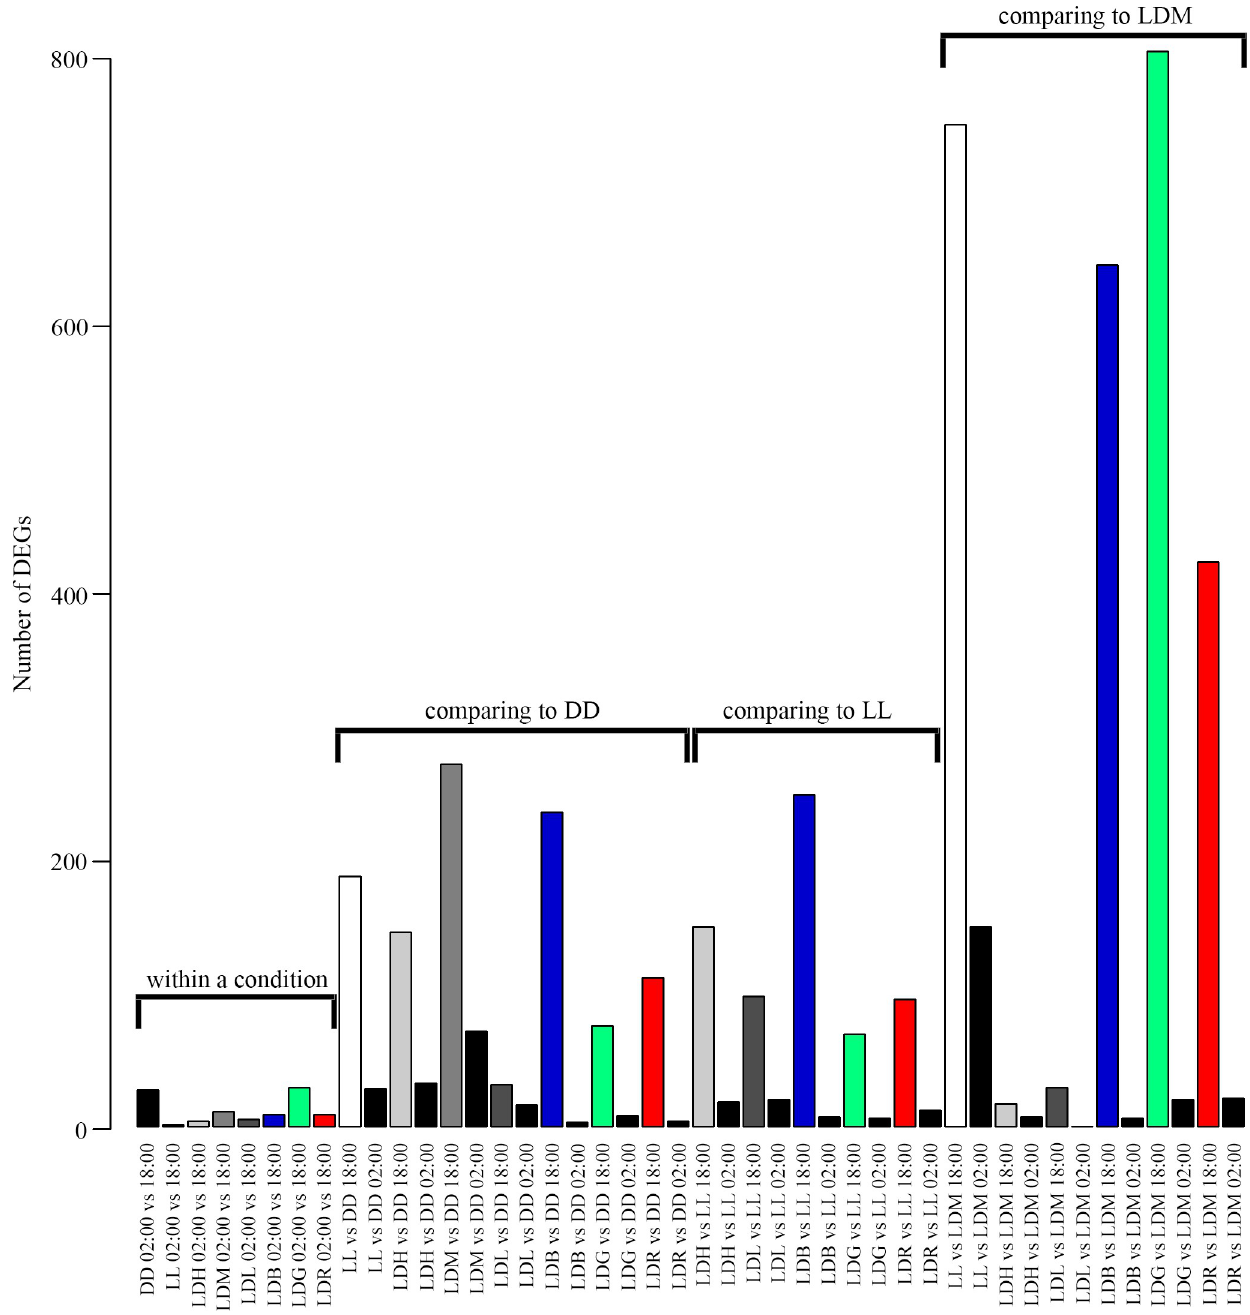
Fig 3. Bar chart comparing differentially expressed genes (DEGs). The bar chart shows the number of DEGs within a light condition comparing the expression at 18:00 and 02:00 (within a condition), between conditions both at 18:00 and 02:00 (comparing to continuous darkness, DD), (comparing to continuous white light, LL) and (comparing to light-dark (LD) of white light of medium intensity, LDM). Few genes were differentially expressed within a condition at 18:00 and 02:00. Comparing the different light conditions to DD, LL or LDM revealed more DEGs 18.00 then 02:00. The color code within a condition is DD (black), LL (white), LDH (light grey), LDM (medium grey), LDL (dark grey), LDB (blue), LDG (green), LDR (red). In comparing to DD, LL and LDM the color at 18:00 is reflecting the condition being examined (as for within a condition), and at 02:00 it is black.